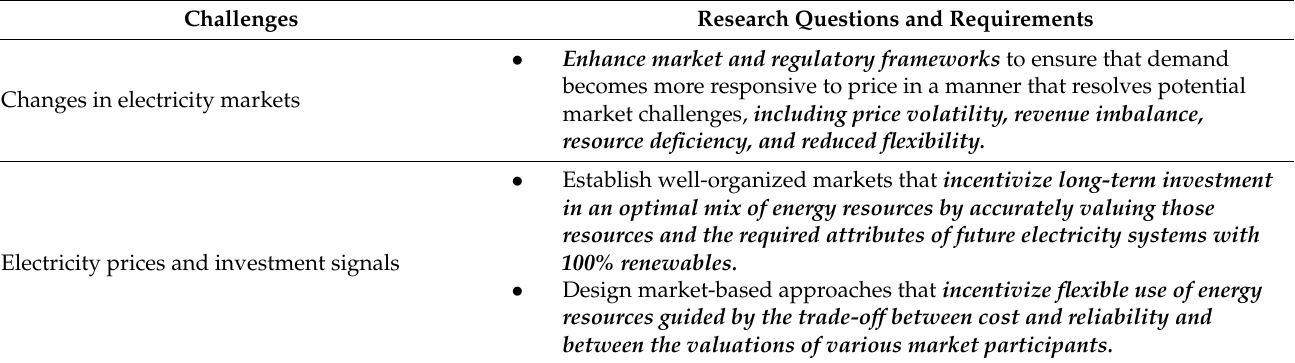
Table 15. List of research challenges in electricity market